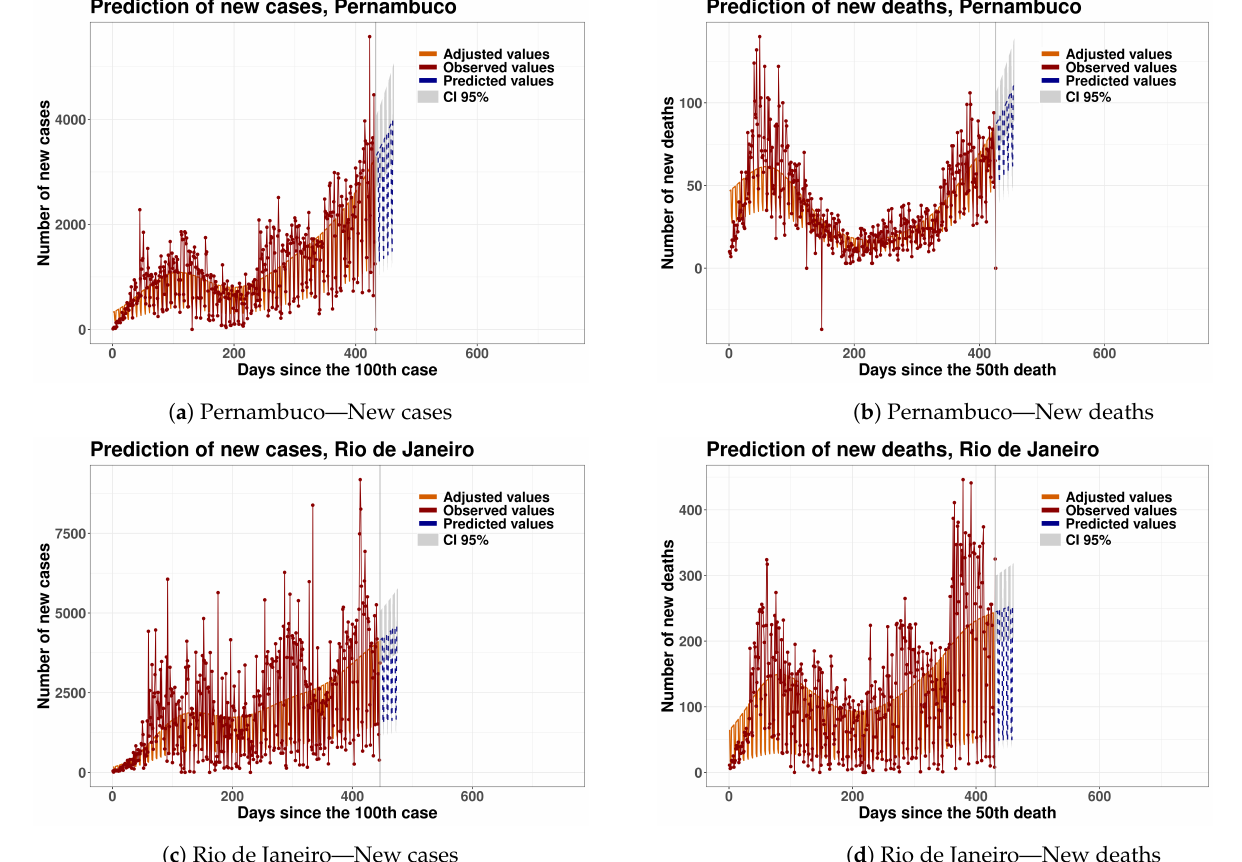
Figure 6. Time series and forecasts via GAMLSS models for new cases and new deaths in the next 30 days for the States of Pernambuco and Rio de